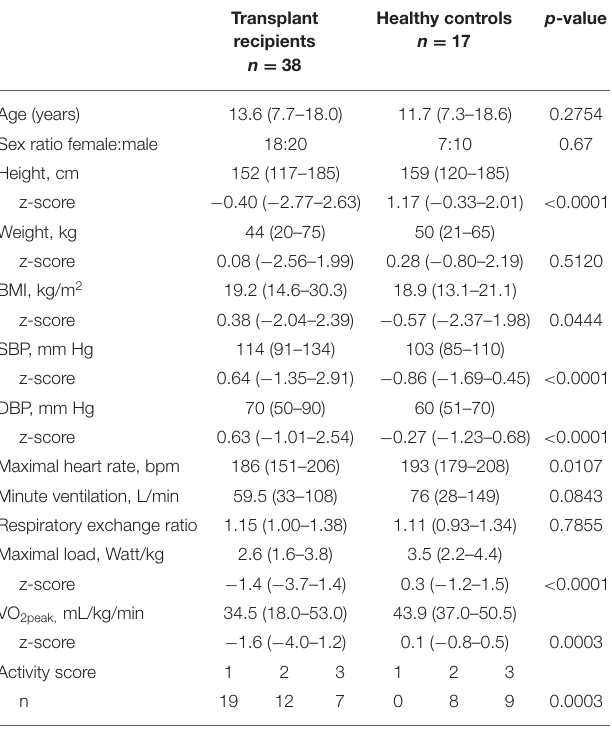
TABLE 2 | Demographic and biochemical characteristics in kidney transplanted children ( n =